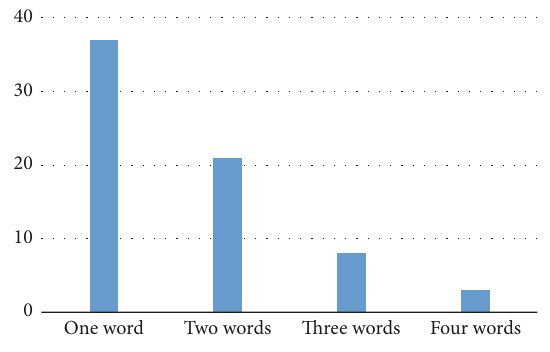
Figure 6: Including a HT to tweet.